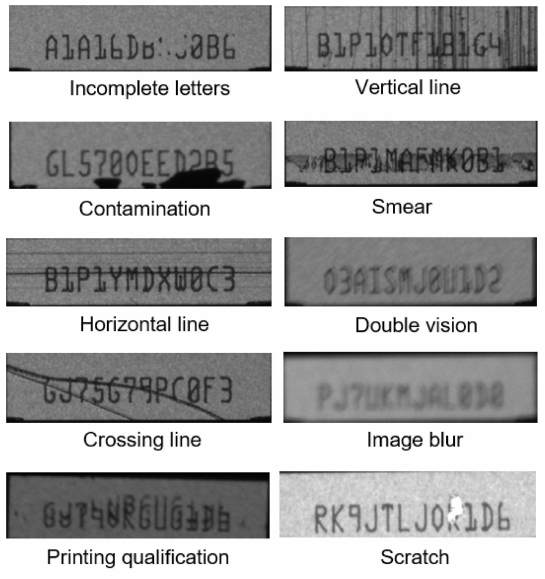
Figure 5. Types of defects on serial number images occurring in a production